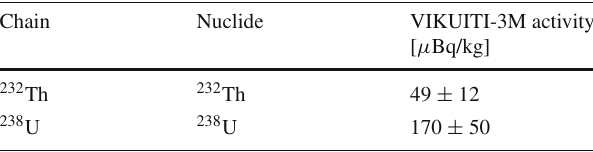
Fig. 6 Light detector before its assembly. The side with the antireflec- tive coating is visible. The coating results in a dark internal circle, while 2 mm on the edge are uncoated Table 2 Bulk contaminations of the VIKUITI-3M light reflector. The measurement was carried out at the LNGS by means of a mineralization procedure and an ICPMS analysis. The overall mass of VIKUITI-3M used in CUPID-0 is 17 g. The total activity is 0.8 ± 0.2 µ Bq and 2.9 ± 0.7 µ Bq for 232 Th and 238 U, respectively